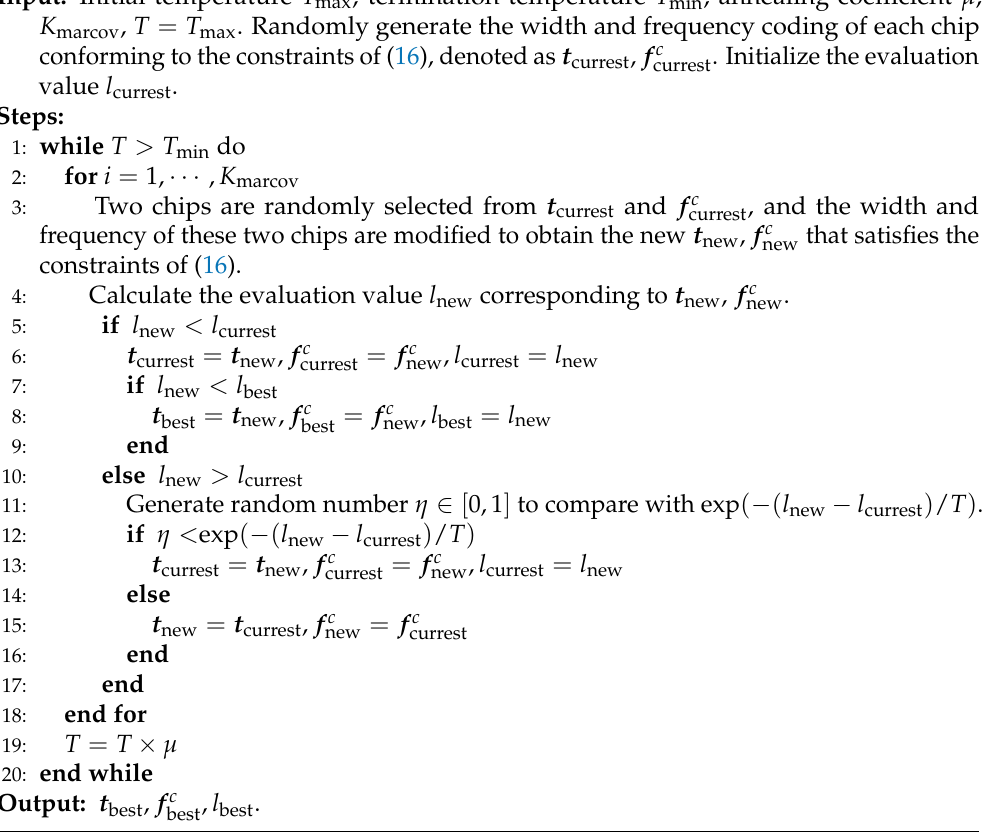
Algorithm 1 Simulated